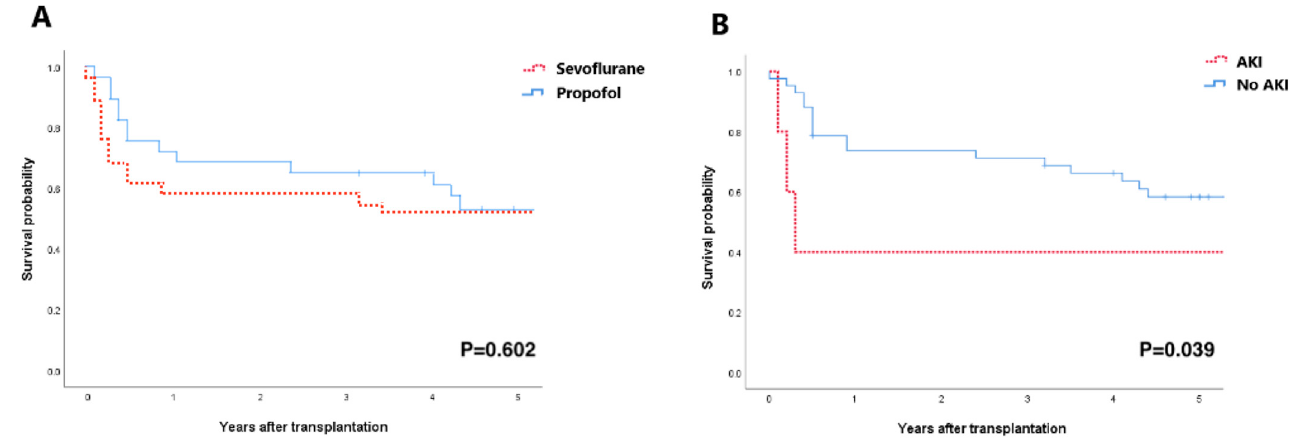
Figure 3. Kaplan–Meier analysis of the 5-year survival rate after surgery. ( A ) Survival curves according to the anesthesia agents. ( B ) Survival curves according to the post-operative AKI development. AKI = acute kidney injury.